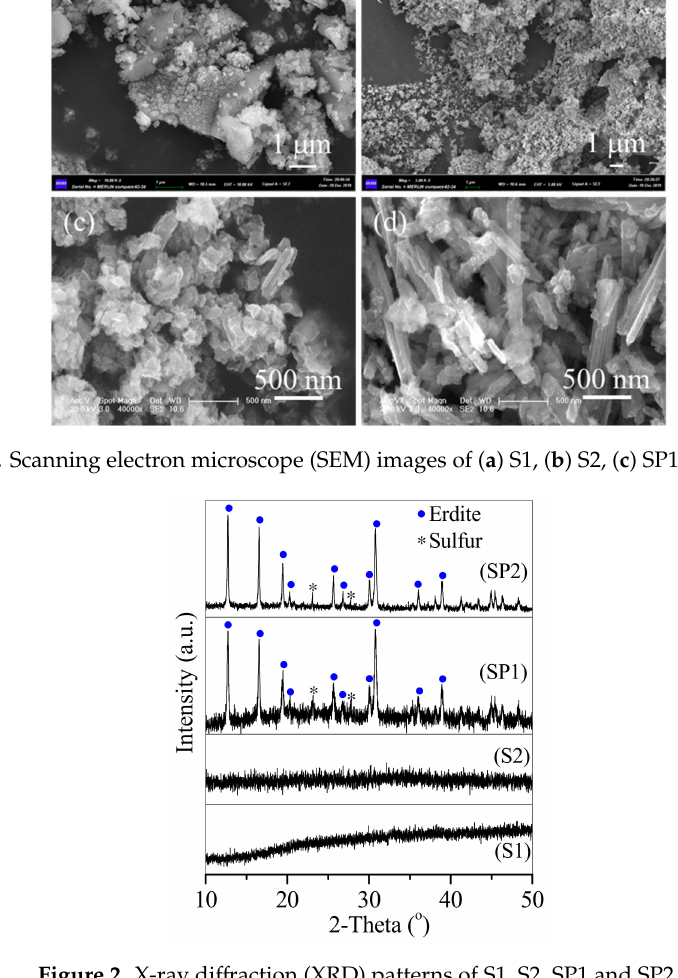
Figure 2. X-ray di ff raction (XRD) patterns of S1, S2, SP1 and